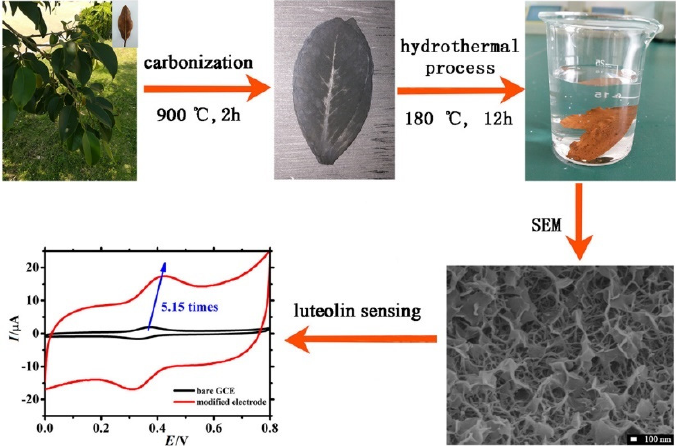
Figure 17. Schematic illustration of the synthesis process of AuNFs-BPC and the LUT electrochemical determination. Reprinted with permission from [136]. Copyright 2021, Elsevier.